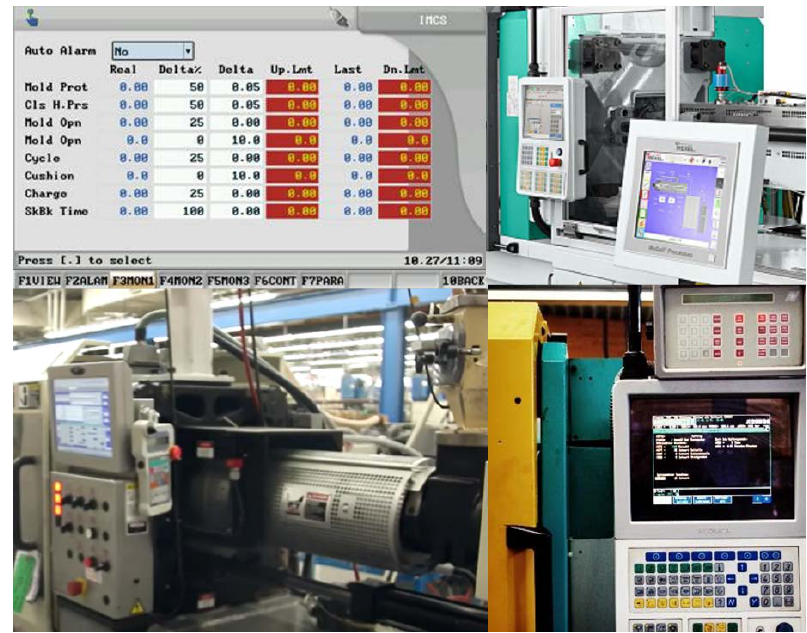
Figure 1. Injection Molding Machine.